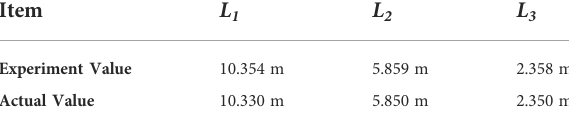
TABLE 3 Comparison of experimental and actual